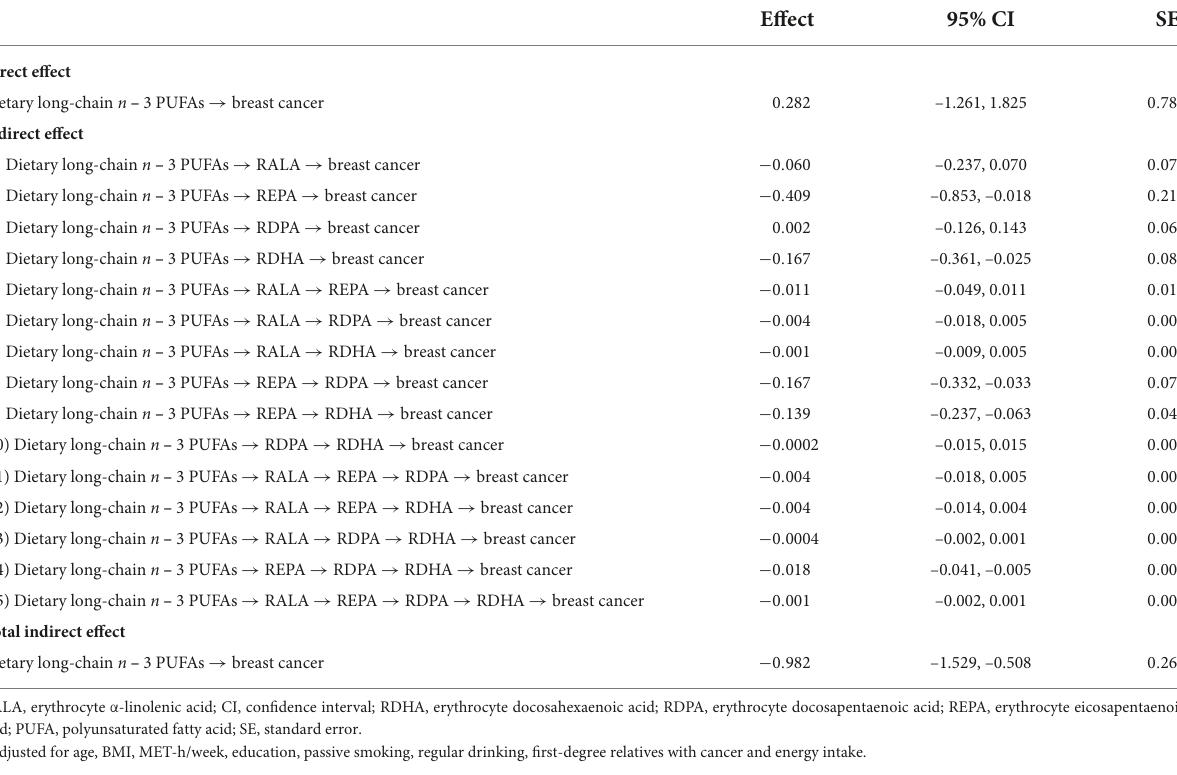
TABLE 5 Direct and indirect effect of the chain mediation model with mediator of erythrocyte n – 3 PUFAs in association between dietary long-chain n – 3 PUFA intake and breast cancer risk a .